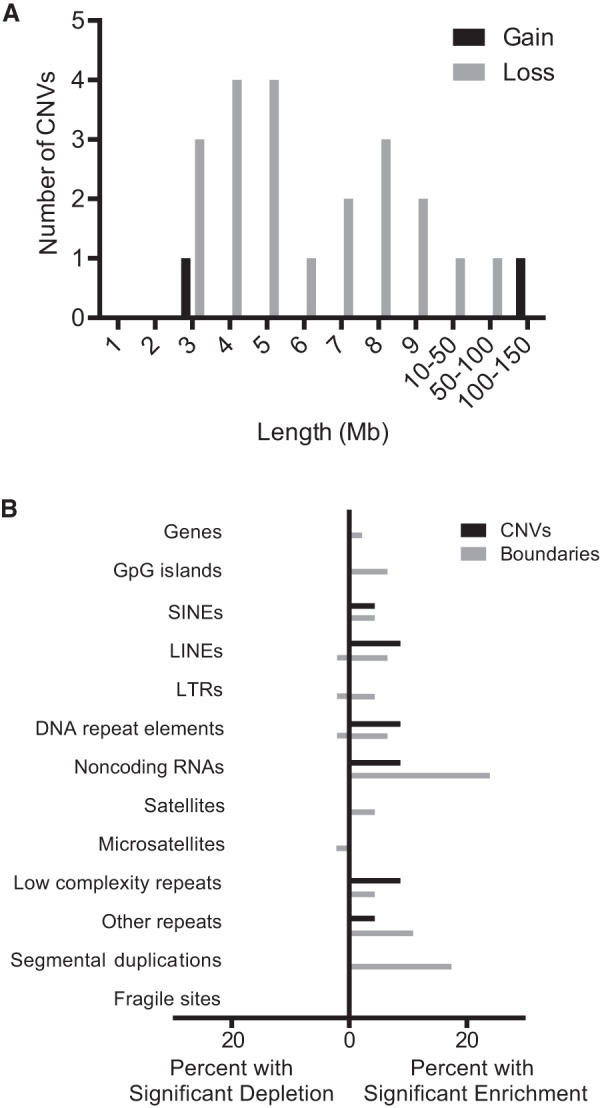
Characteristics of megabase-scale CNVs in somatic cells. (A) The distribution of CNV length among CNVs identified in brain and skin cells with VS <0.26. (B) The percentage of CNVs and CNV boundaries showing significant enrichment or depletion of various genomic features.